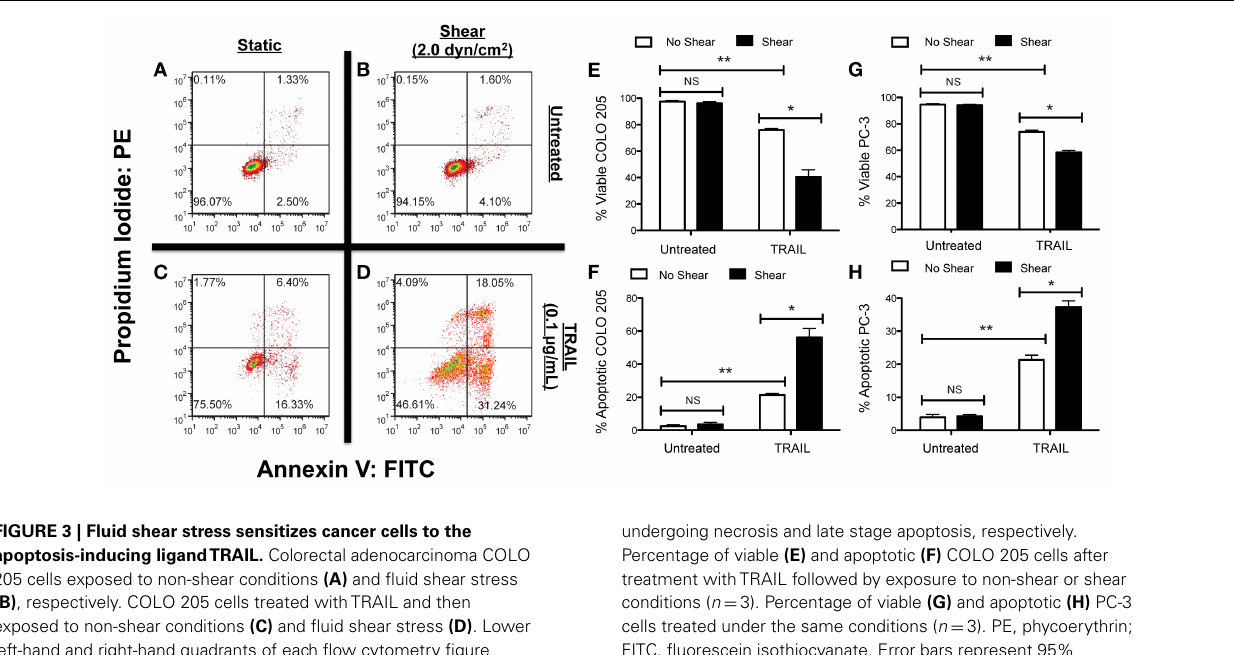
FIGURE 3 | Fluid shear stress sensitizes cancer cells to the apoptosis-inducing ligandTRAIL. Colorectal adenocarcinoma COLO 205 cells exposed to non-shear conditions (A) and fluid shear stress (B) , respectively. COLO 205 cells treated withTRAIL and then exposed to non-shear conditions (C) and fluid shear stress (D) . Lower left-hand and right-hand quadrants of each flow cytometry figure represent viable cells and cells in early stages of apoptosis, respectively. Upper left-hand and right-hand quadrants represent cells